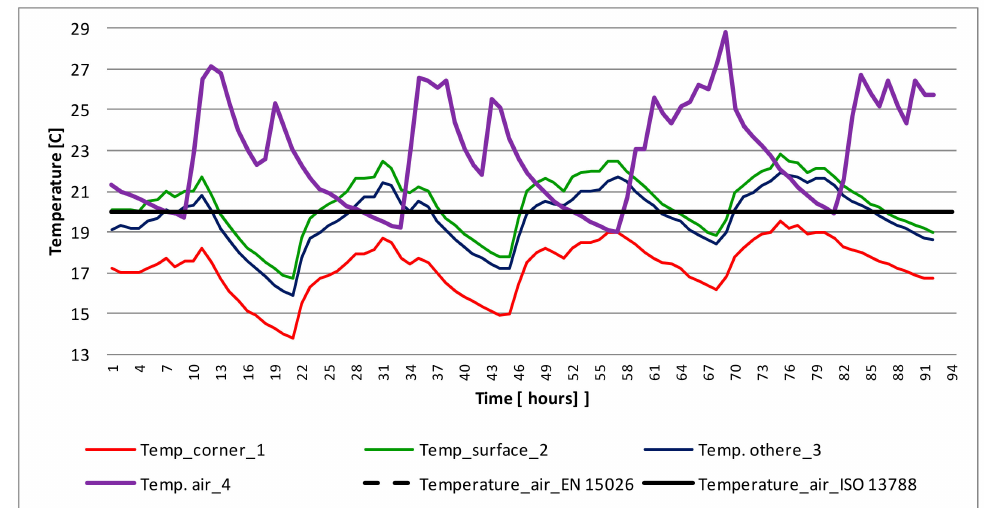
Figure 10. Changes of indoor air temperature for the room with external walls W_1 (symbols as in the picture Figure 5).